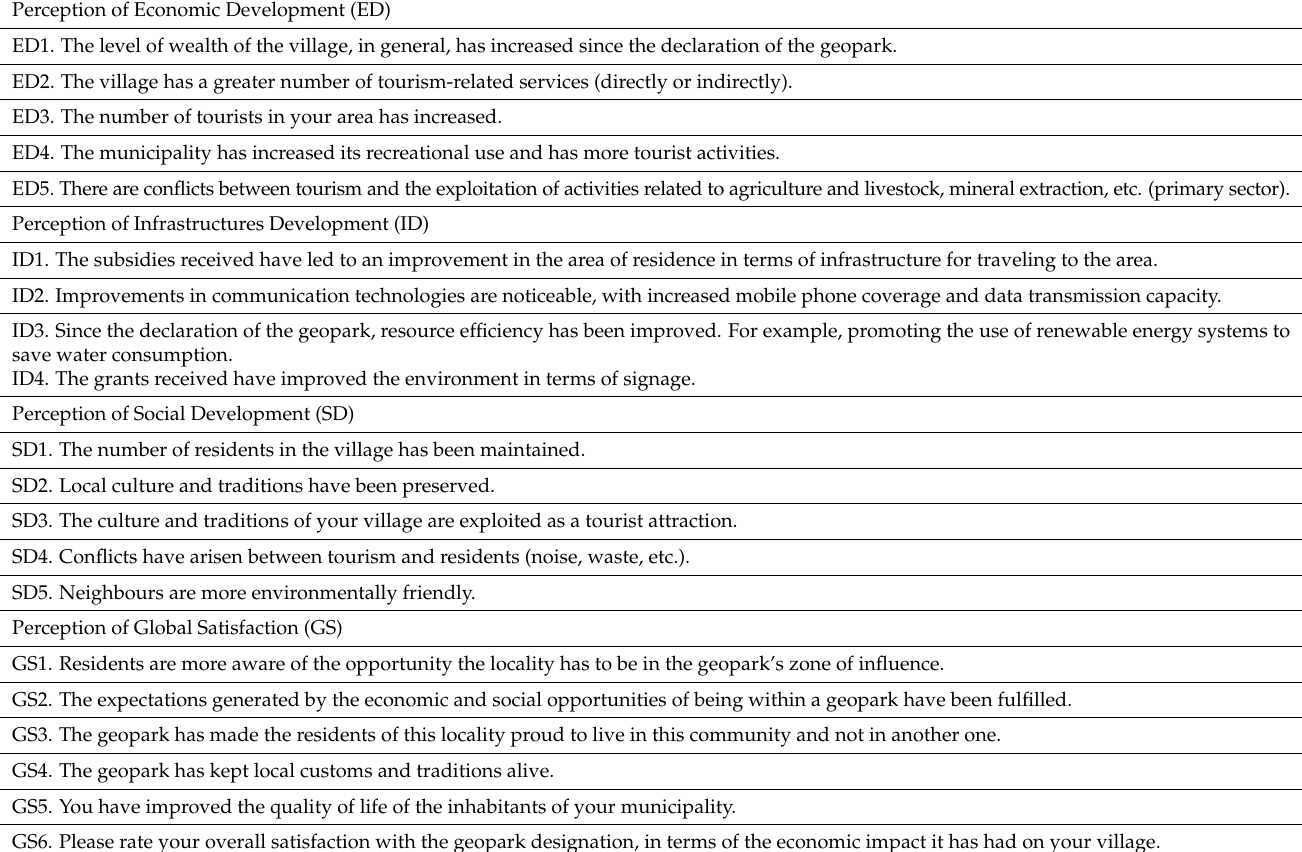
Table A1. Questionnaire. Item